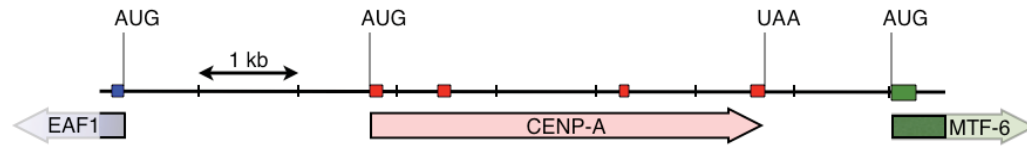
Figure 2. Schematic representation of the Tallapoosa darter CENP-A gene structure, the upstream location of exon 1 of the EAF1 gene and the downstream location of the methyltransferase-like protein 6 gene.